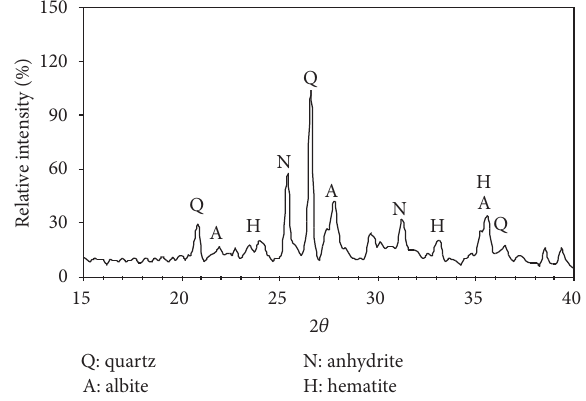
F 1: e XRD pattern of sewage sludge